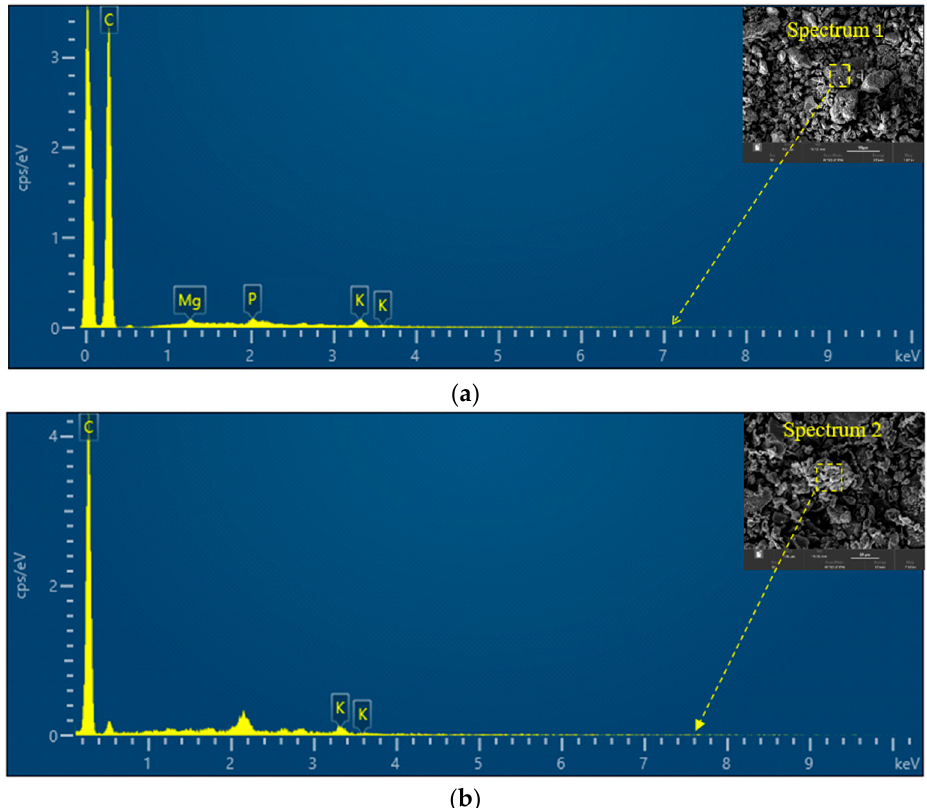
Figure 5. EDX analysis for charge: ( a ) activated carbon at 400 °C and ( b ) activated carbon at 1000 °C.